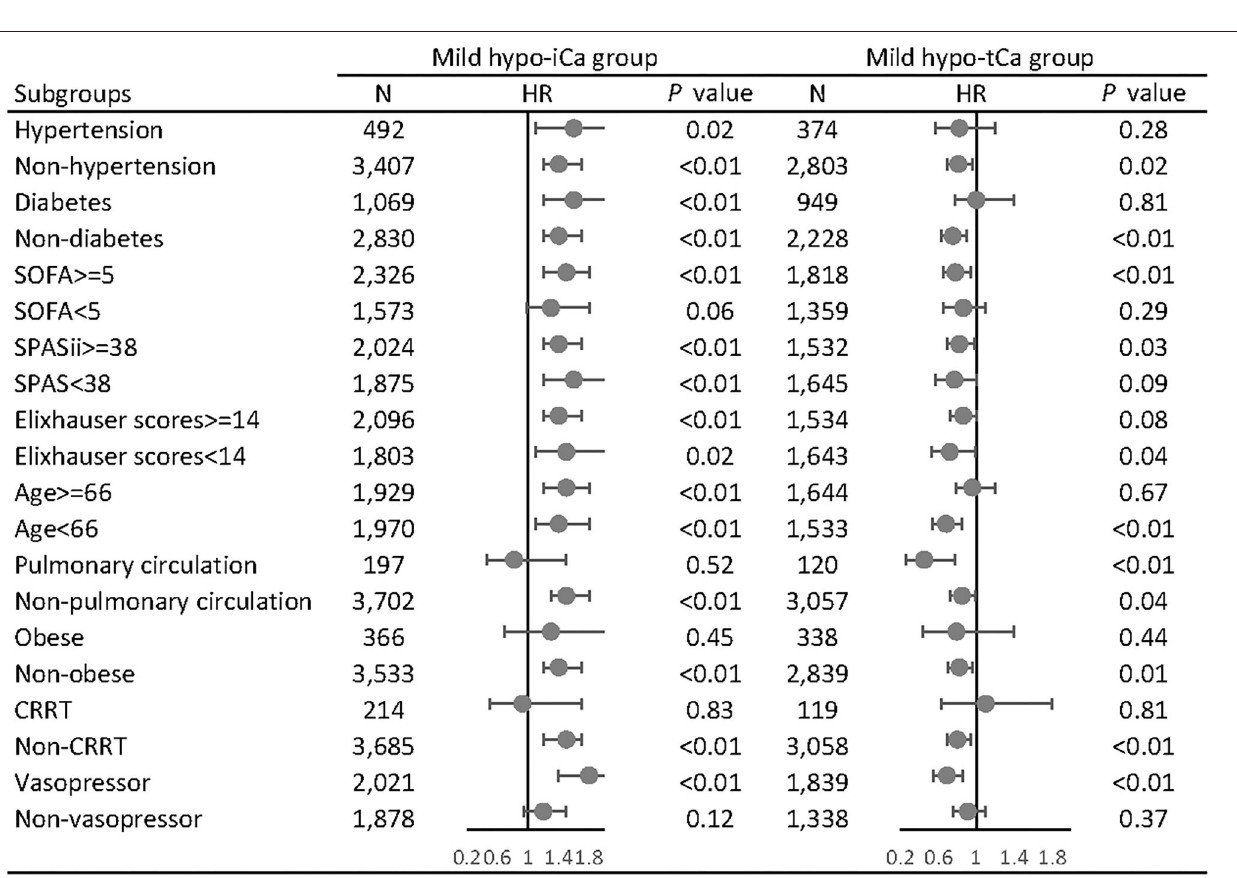
FIGURE 4 | Subgroup analysis of the associations between mild hypocalcemia and 28-day all-cause mortality in MIMIC III database. The forest plot represents the hazard ratios (HR) and 95% confidence intervals (error bars).